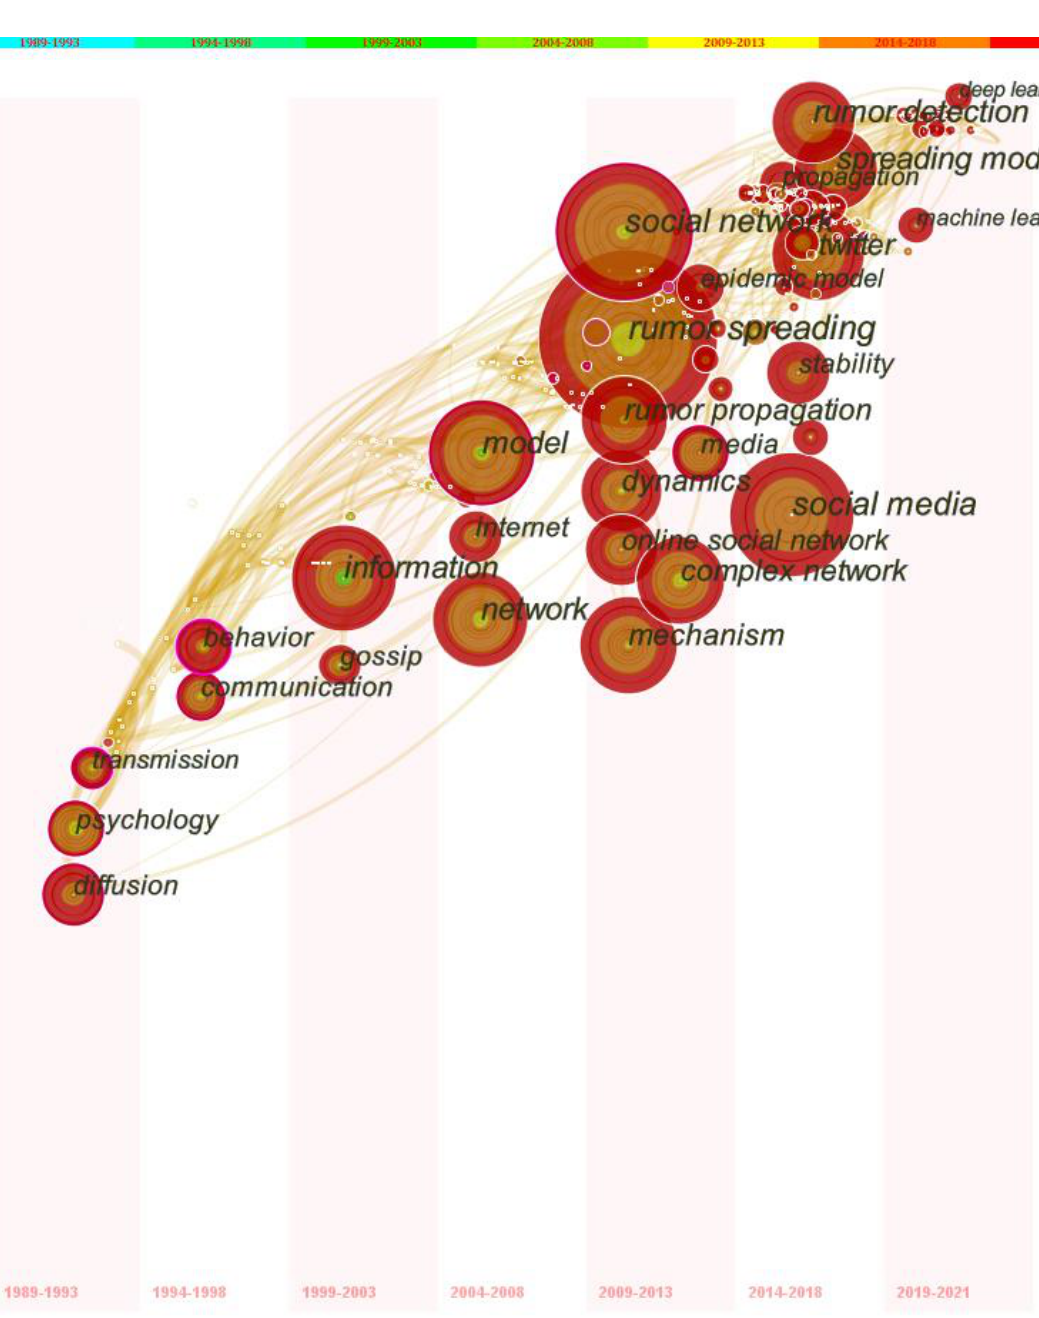
Figure 5. Appearance time of keywords. (The color of a ring denotes the time of appearance; the thickness of a ring is proportional to the number of appearance frequency in a given time slice; the link between different keywords denotes co-occurrence in the same paper.).